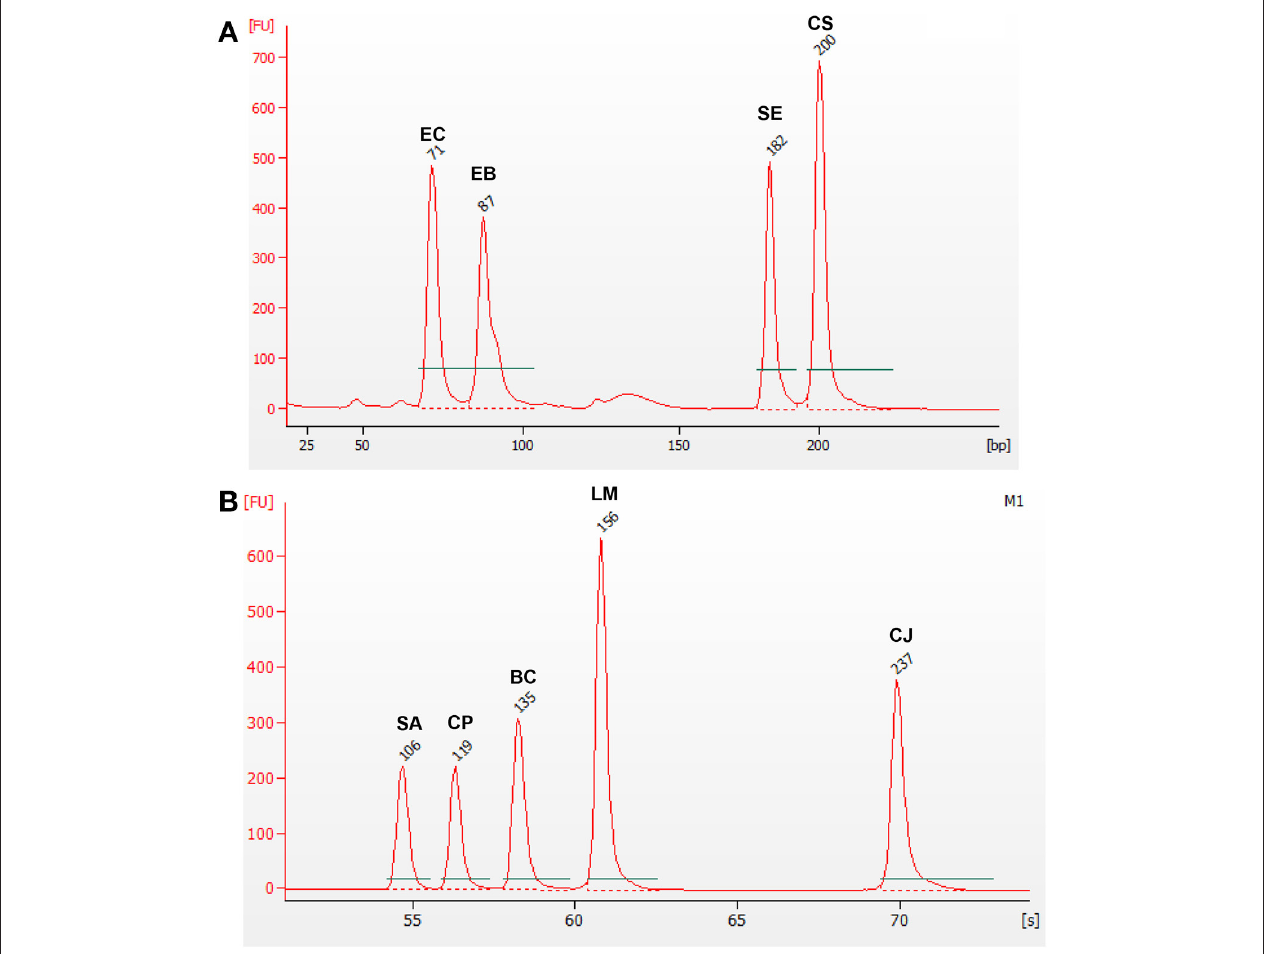
FIGURE 3 | mPCR using gDNA from two groups of microorganisms. Electropherogram (A) corresponds to Enterobacteriaceae microorganisms : Cr. sakazakii (CS) , E. coli (EC), Salmonella spp. (SE), and F. Enterobacteriaceae (EB); while electropherogram (B) corresponds to the non- Enterobacteriaceae microorganisms: B. cereus (BC) , C. jejuni (CJ) , Cl. perfringens (CP), L. monocytogenes (LM), and St. aureus